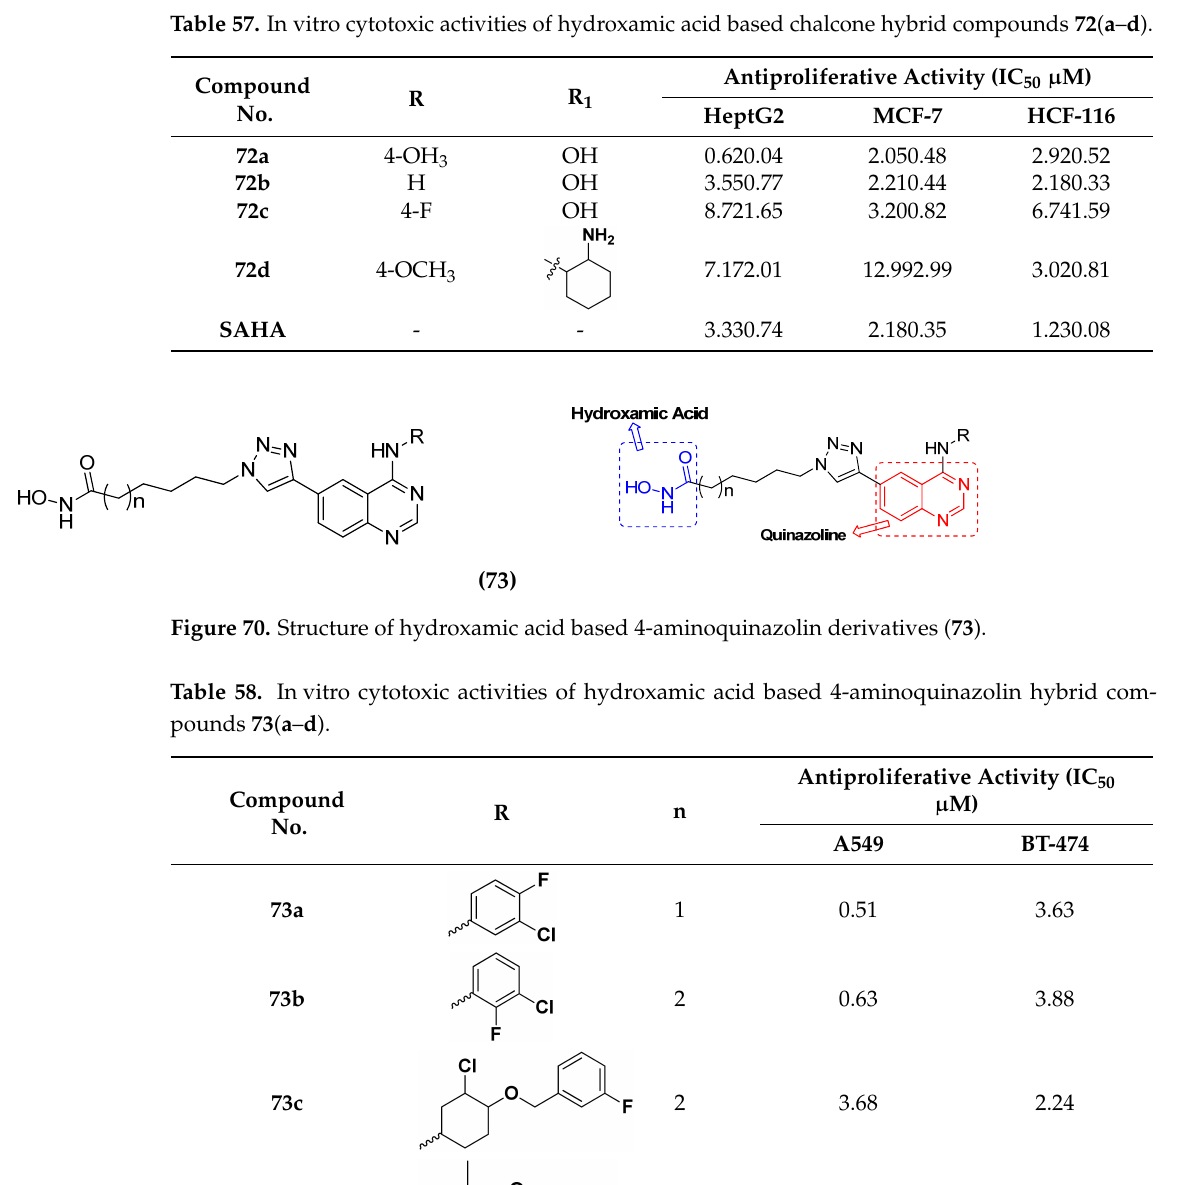
Figure 69. Structure of hydroxamic acid based chalcone derivatives ( 72 ). Table 57. In vitro cytotoxic activities of hydroxamic acid based chalcone hybrid compounds 72 ( a – d ).